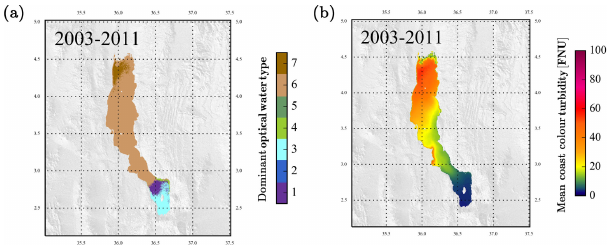
Figure 5. Nine-year aggregated OWT in Lake Turkana ( a ; owt_cc_dominant_class_mode ), which features a very prominent gradient in turbidity ( b ; turbidity_cc_mean ). Maximum turbidity and predominantly OWT 7 are observed in the north, where its main tributary, the Omo River, provides about 90% of the lake’s inflow (Beadle, 1981). In contrast, the terminal basin in the south corre- sponds to OWT 1 and 3, which are second and third lowest in tur- bidity according to the end members in Fig.